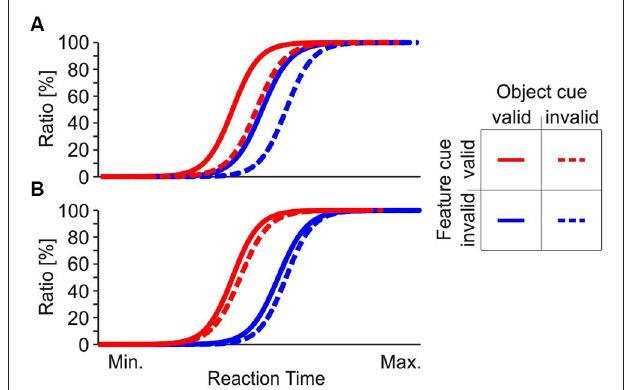
FIGURE 1 | Hypothetical RT distributions. (A) Cumulative RT distribution compatible with an object-based attention approach. Task-irrelevant features are associated with faster RTs if they belong to the attended object, as indicated by a leftward shift of the RT distributions for invalidly cued features. (B) Cumulative RT distribution incompatible with a strict object-based attention approach. Here, object cueing is ineffective (i.e., a valid object cue has no influence or has an equal influence at both objects) and RTs are influenced solely by the feature cue, as indicated by overlaying RT distributions for corresponding feature cue